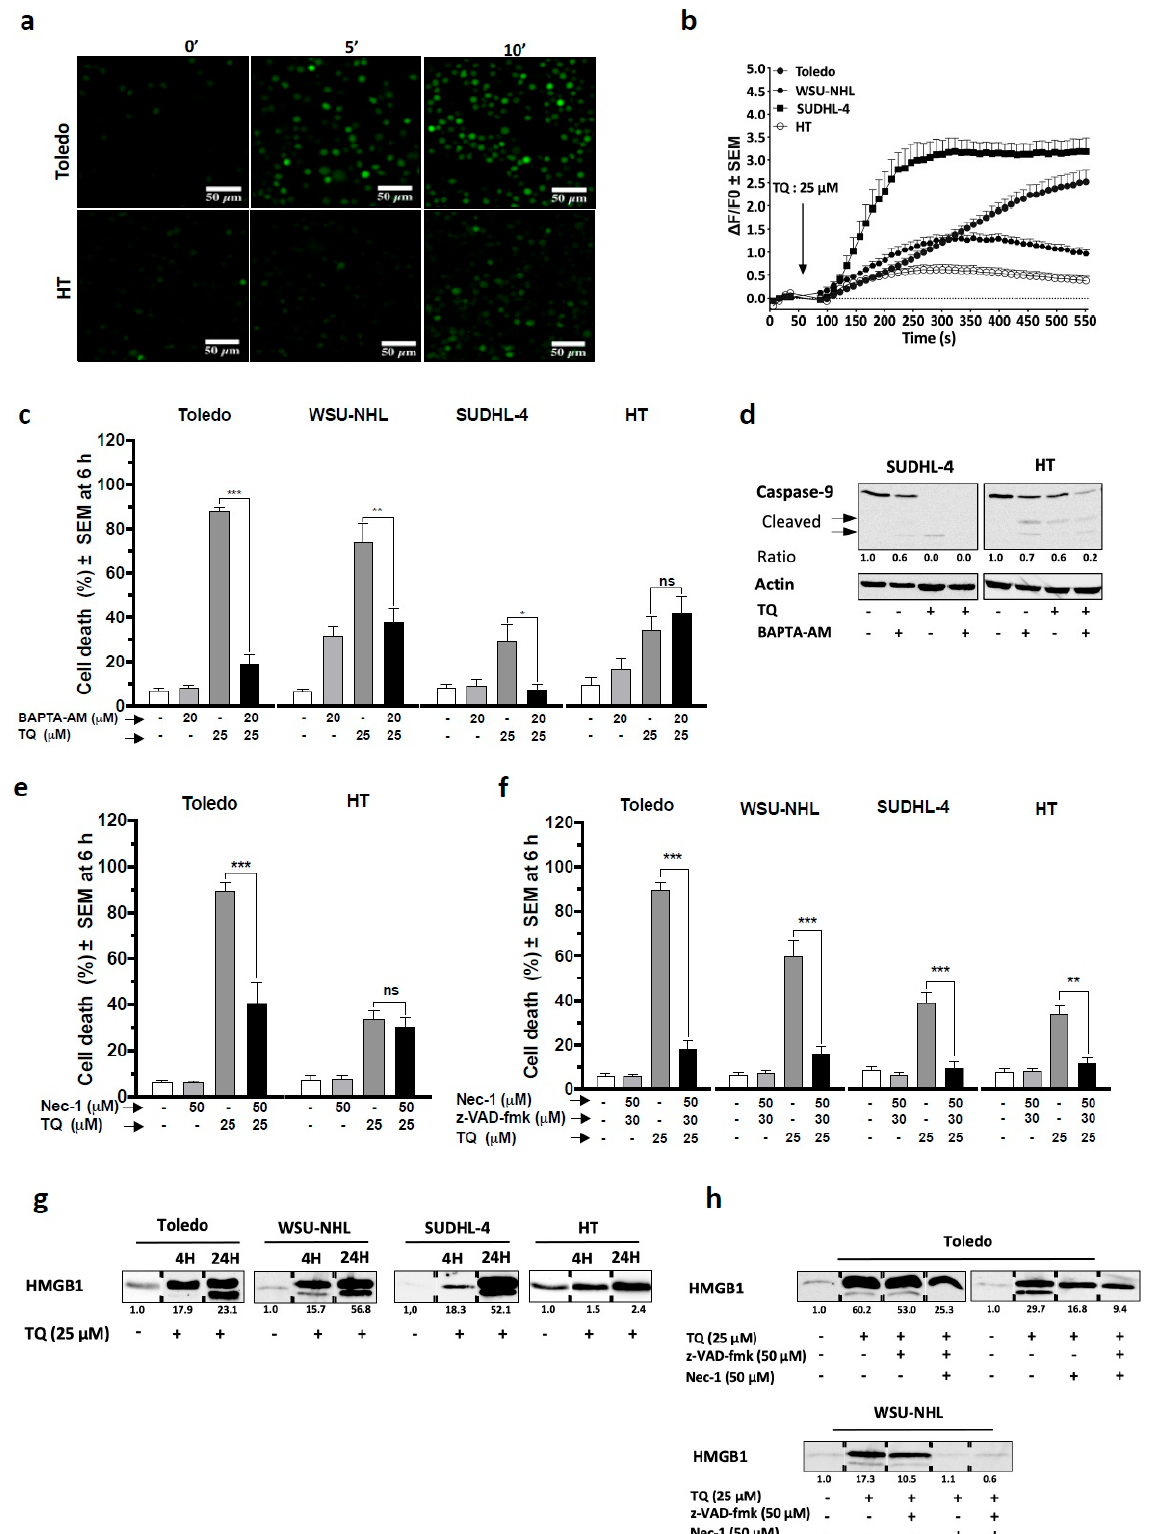
Figure 4. Role of cytosolic calcium efflux and necroptosis-like activity in TQ-induced non-apoptotic cell death. ( a , b ) Cytosolic calcium mobilization was monitored by fluorometric analysis using the Ca 2+ indicator FLUO-4 AM. ( a ) A fluorescence imaging of Toledo and HT cells treated with 25 µ M TQ for 10 and 30 min. ( b ) Cells were loaded with FLUO-4 AM, and emitted fluorescence was monitored from 1 s to 540 s via flow cytometry in all cell lines; treatment with 25 µ M